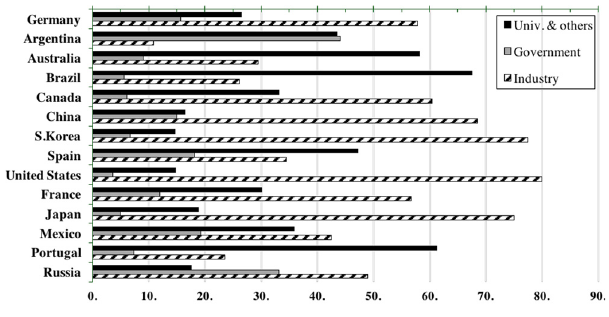
Figure 1. Participation